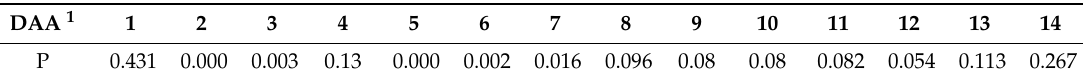
Figure 3. Number of cheeseweed plants emerging in pots that received 25 mL of OVW at five different strengths diluted with tap water (T1: 0% OVW, T2: 25% OVW, T3: 50% OVW, T4: 75% OVW, T5: 100% OVW). Error bars represent ± standard error. Table 5. P values for effect of 25 mL olive vegetation water application on cheeseweed emergence in soil-filled pots.